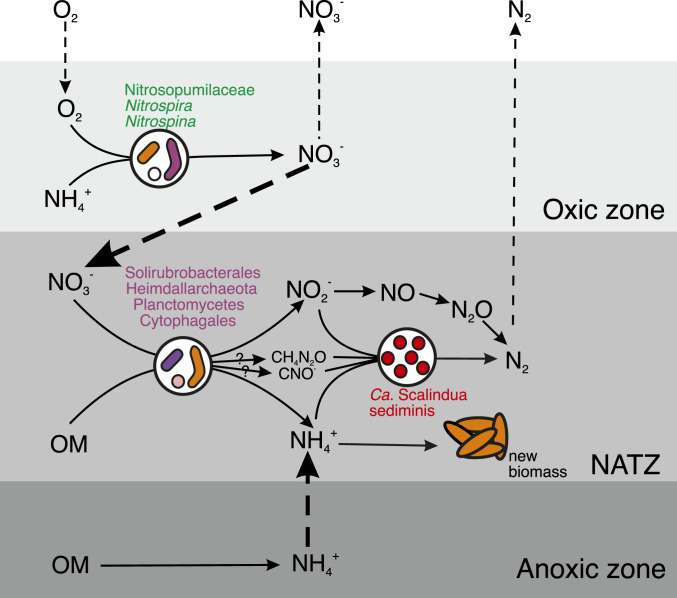
Conceptual model of Ca. Scalindua thriving in the NATZ and their dependencies on other microbial guilds and processes. Metabolism of Ca. Scalindua depends on both reduced nitrogen (ammonium) and oxidized nitrogen (nitrite). The ammonium source of Ca. Scalindua in the NATZ is mainly from the upward diffusive flux of NH4+ from the anoxic zone, while local organic matter degradation by denitrifying bacteria and urea and cyanate degradation of Ca. Scalindua can also release NH4+. For the nitrite source, Ca. Scalindua probably rely on the activity of nitrate-reducing bacteria, which generates nitrite by reducing nitrate, mainly produced by nitrifiers in the overlying oxic zone and diffusing downward into the NATZ. In addition to the anammox reaction, nitrite can be consumed by denitrifying bacteria and ammonium can be assimilated to generate new biomass by local organisms such as Ca. S. sediminis. OM, organic matter.